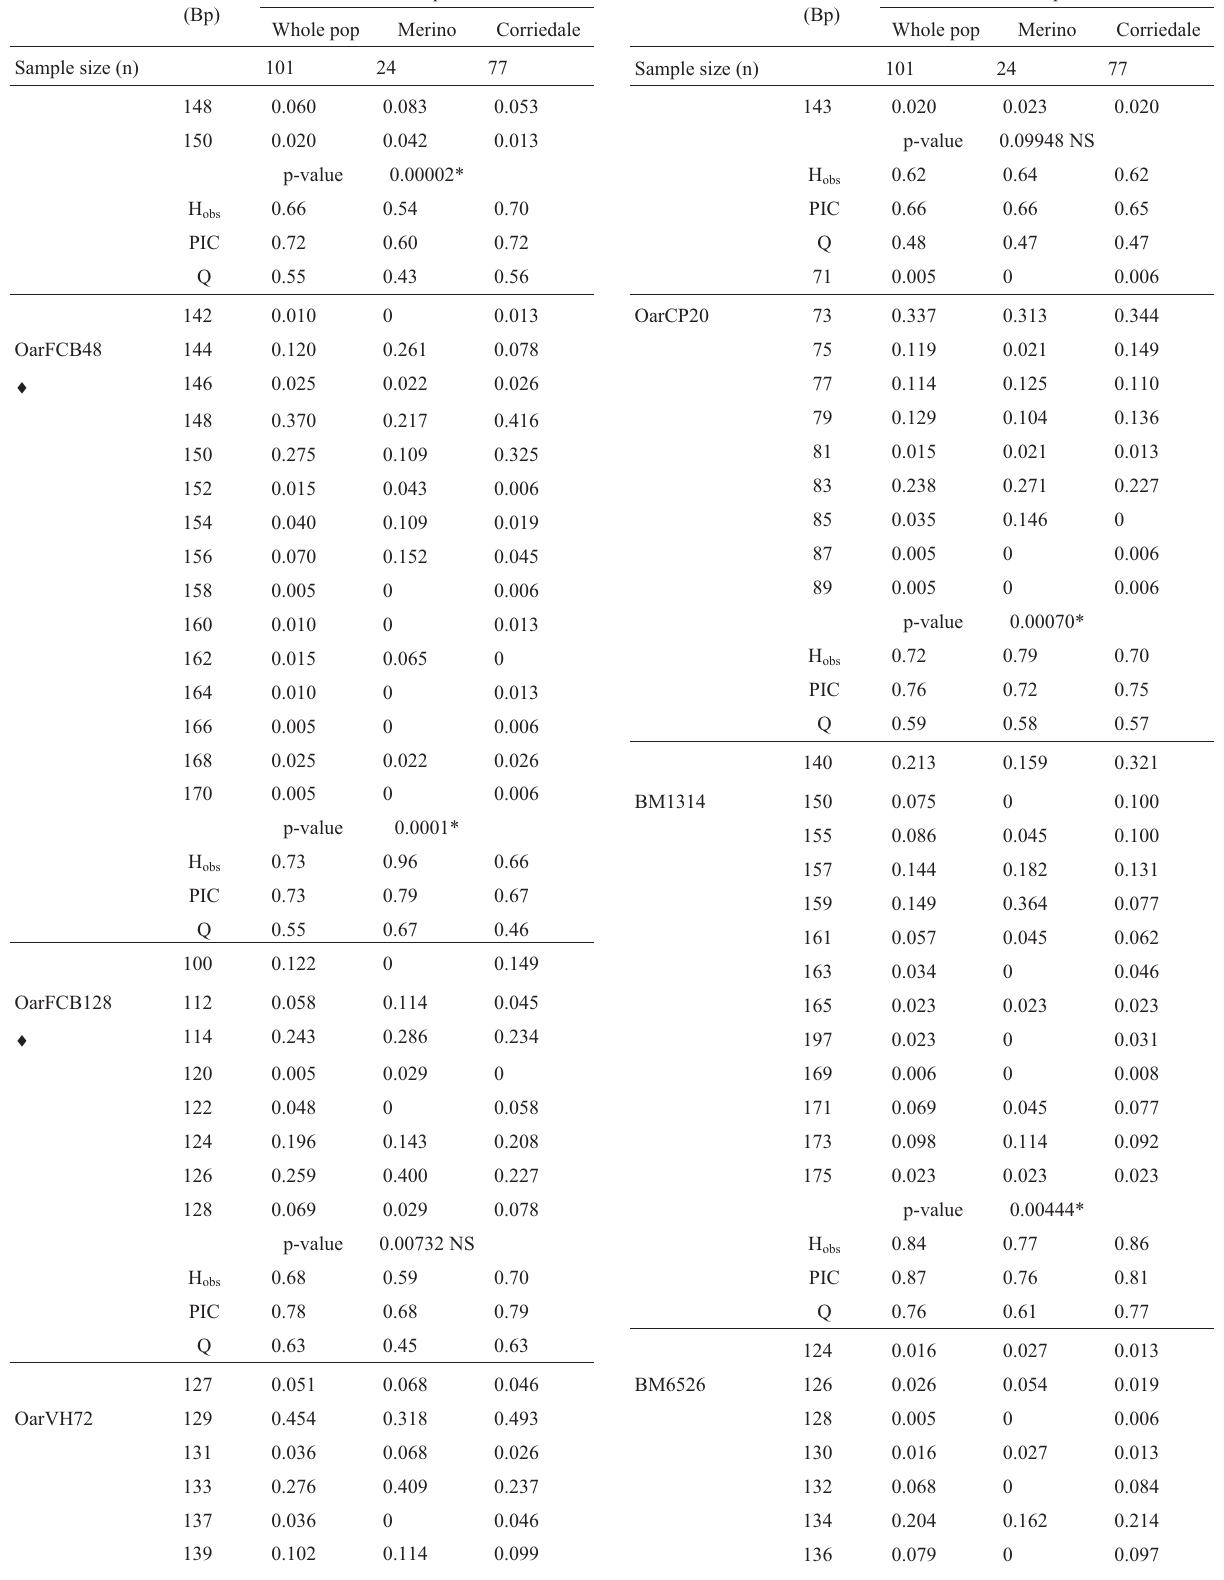
Table I (cont.) Locus Allele size